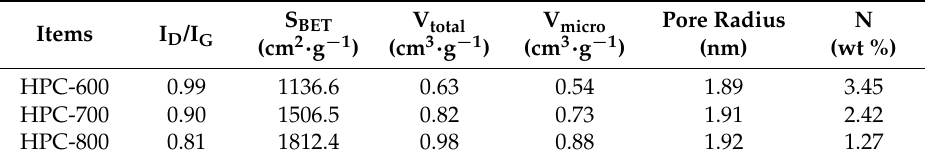
Table 1. Textural Properties of the HPCs.